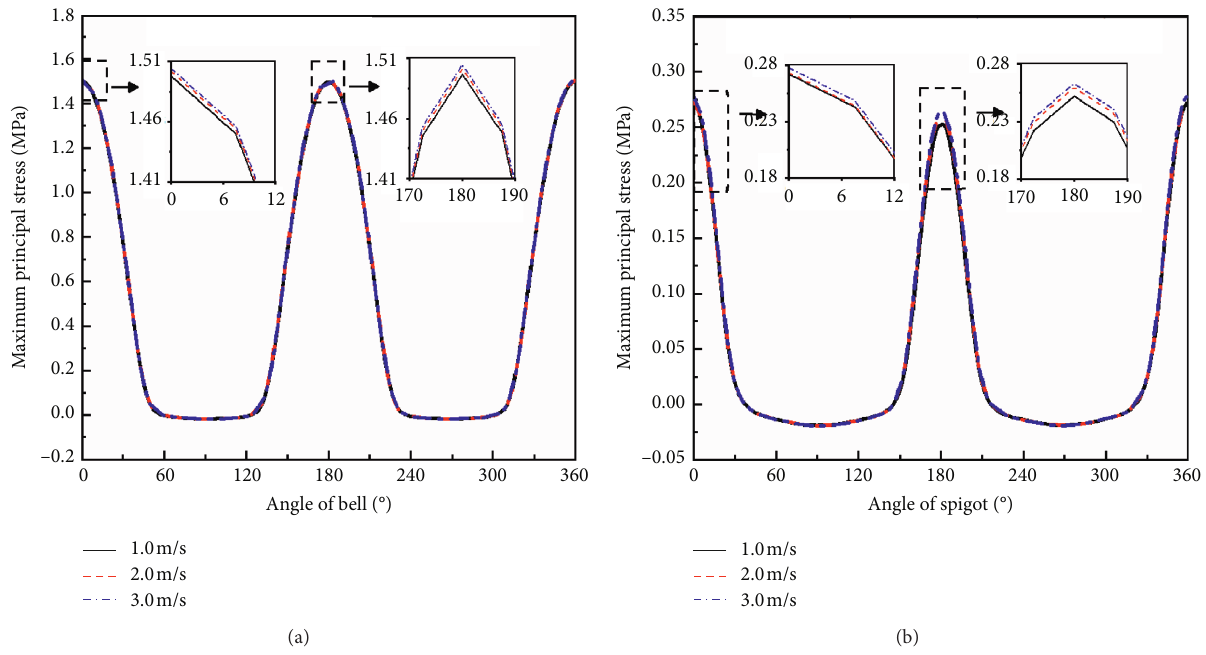
Figure 11: Maximum principal stress of (a) the bell and (b) the spigot under different flow velocities.